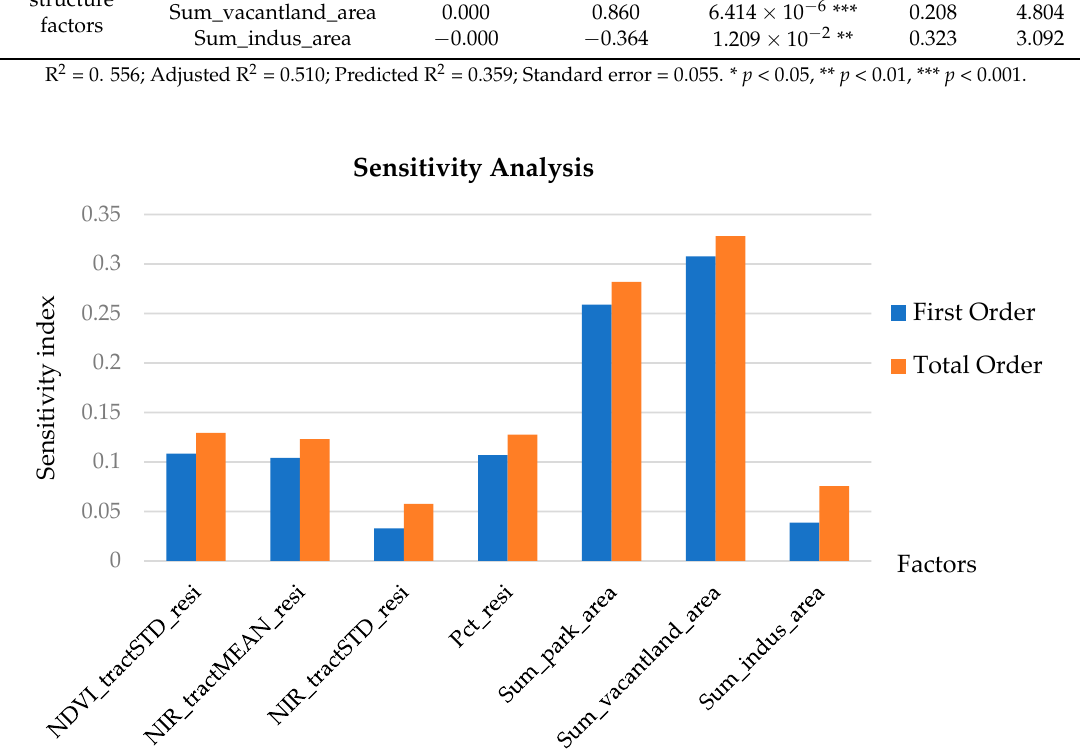
Figure 6. Sensitivity analysis of Stepwise Multivariate Linear Regression Model 1 (without Jilin1-03 satellite NTL